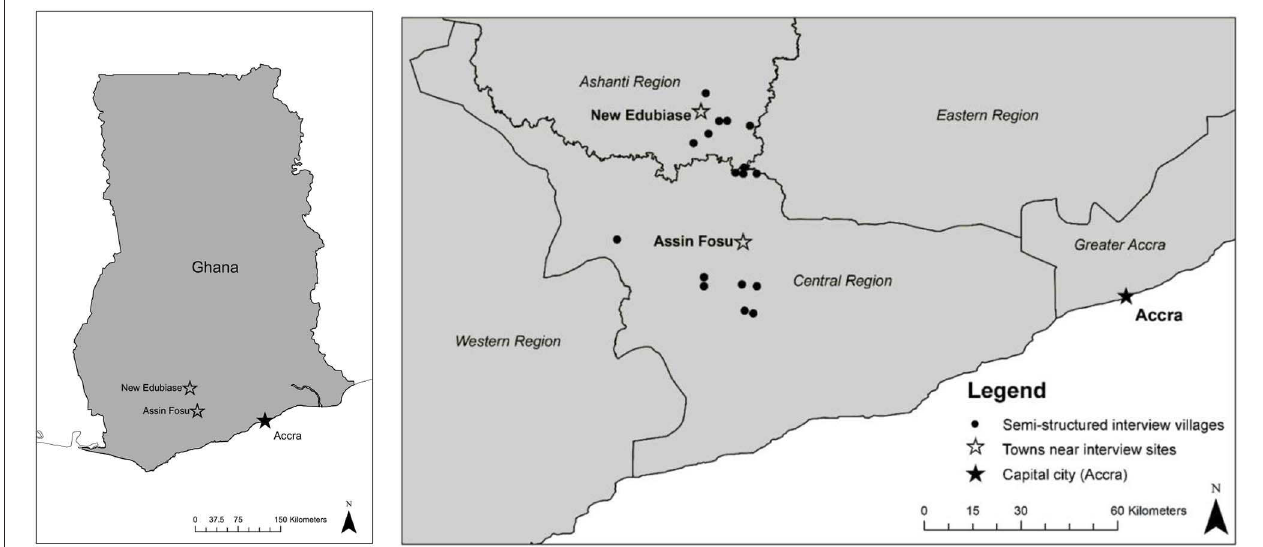
FIGURE 1 | (Left) A map of Ghana, with the capital city of Accra as a black star, and the towns of Assin Fosu and New Edubiase as white stars. (Right) A map of Ghana zoomed in to show study sites, where studied villages are approximately located by circles, and as per the left panel the towns of Assin Fosu and New Edubiase are white stars, and Accra city a black